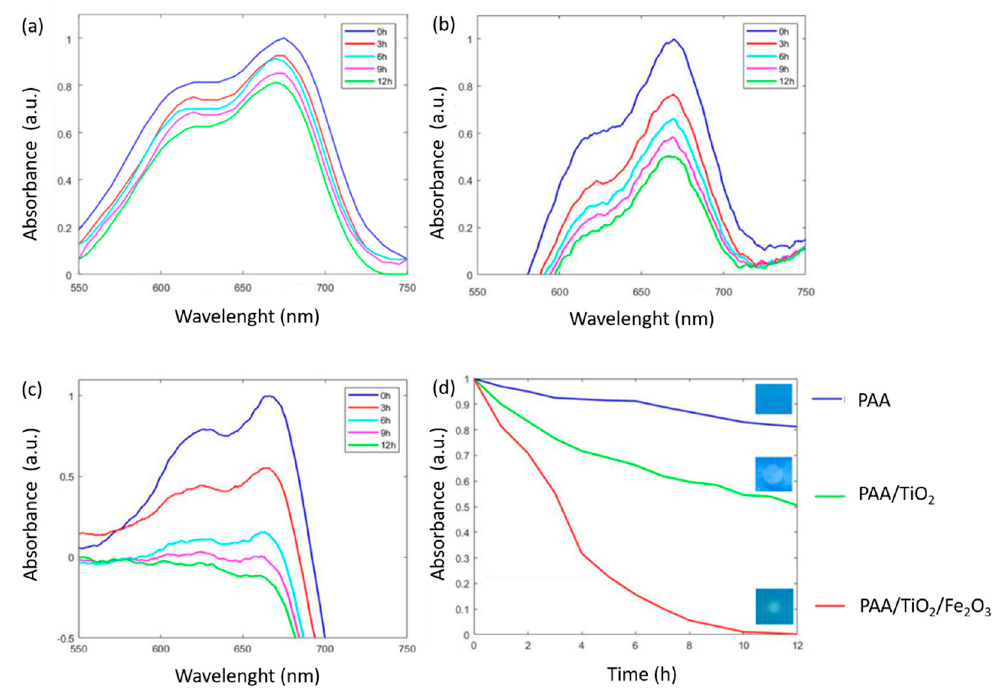
Figure 11. UV-Vis spectra changes of the MB-doped electrospun samples after UV-Vis irradiation for PAA + β -CD ( a ), PAA + β -CD + TiO 2 ( b ), PAA + β -CD + TiO 2 + Fe 2 O 3 ( c ) and a comparative evolution of all the samples of study with the final aspect of coatings after 12 h of irradiation ( d ).